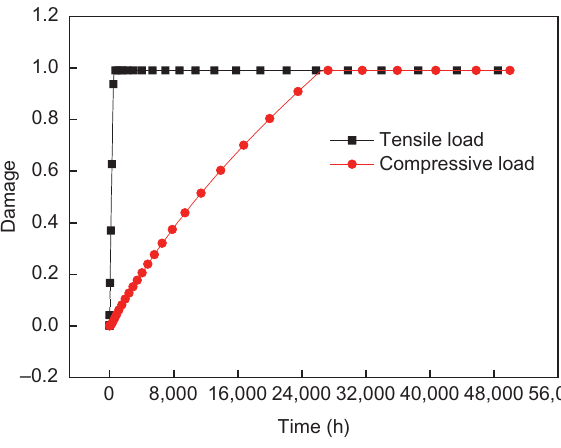
Figure 10: Damage change with time at the fillet at compressive and tensile